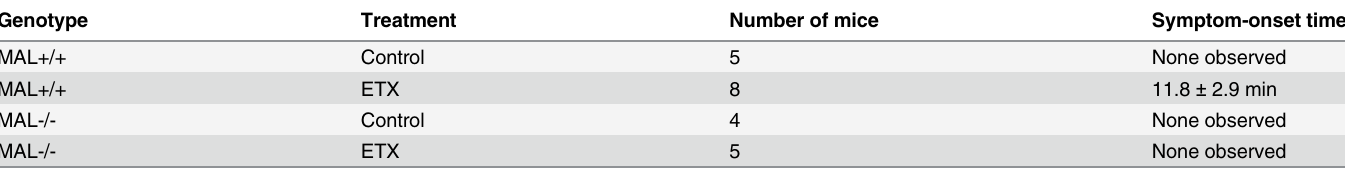
Table 1. Symptom-onset time following ETX administration in